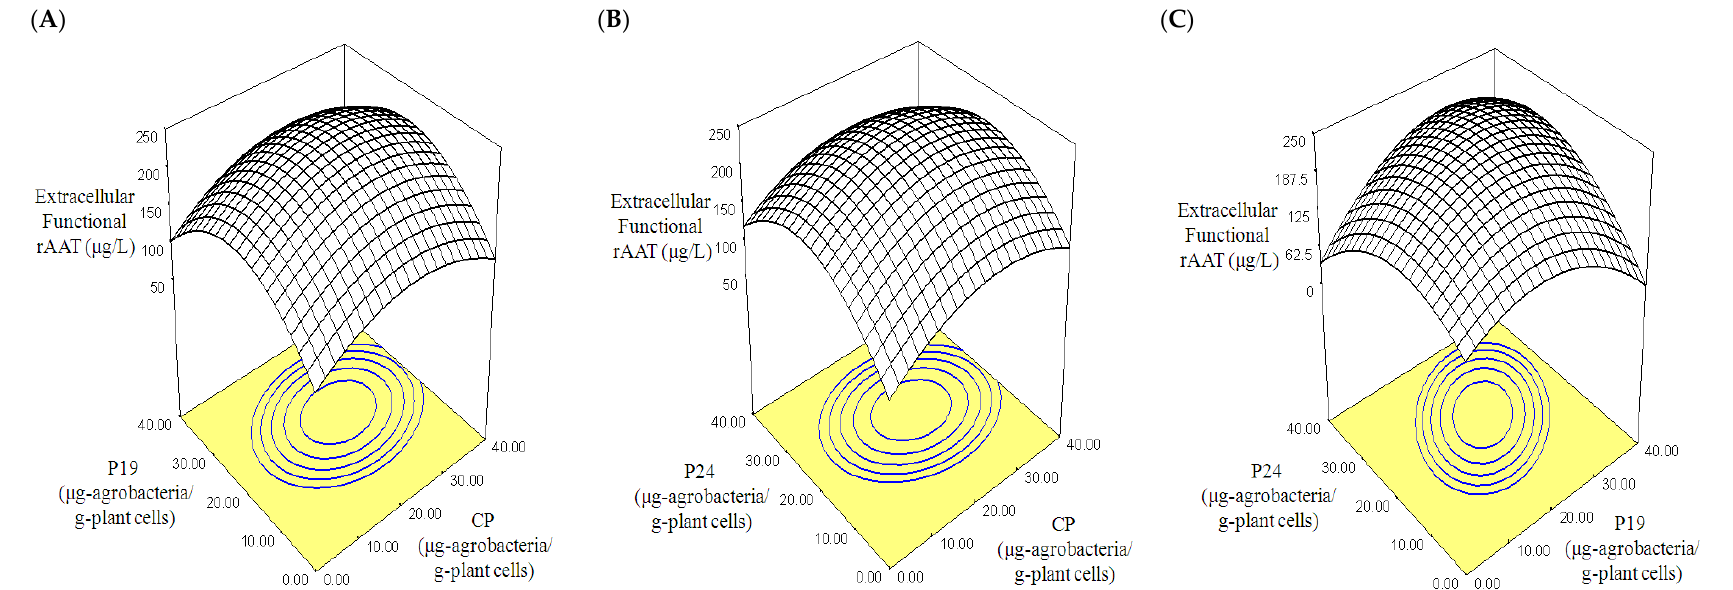
Figure 9. Response surfaces and contour plots ( A – C ) for response of extracellular functional rAAT production in transgenic CMViva cell culture (samples were taken on day 6 post ‐ induction) with a variety of biomass ratio of Agrobacterium carrying viral gene silencing suppressors (CP, P19, or P24) to plant cells ( μ g ‐ Agrobacterium /g ‐ Plant cells), showing the strong interactive effects.